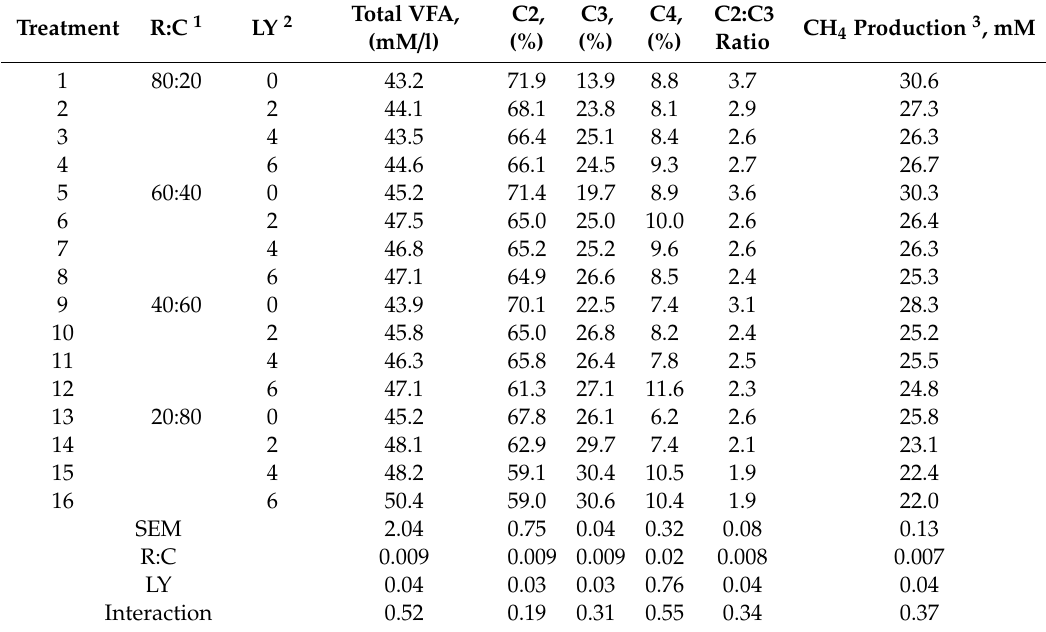
Table 4. The e ff ect of roughage-to-concentrate (R:C) ratio with live yeast (LY) supplementation on in vitro total volatile fatty acids (TVFA), VFA profiles, and methane (CH 4 )